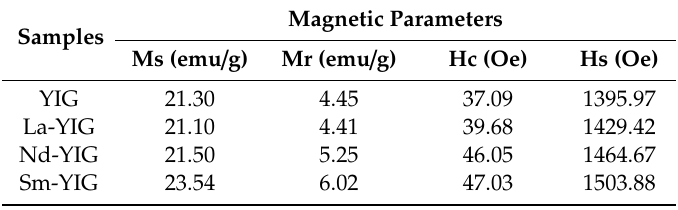
Figure 4. Variation of magnetic saturation with RE-YIG samples. Figure 3. Magnetic hysteresis loop of RE-YIG nanoparticles.